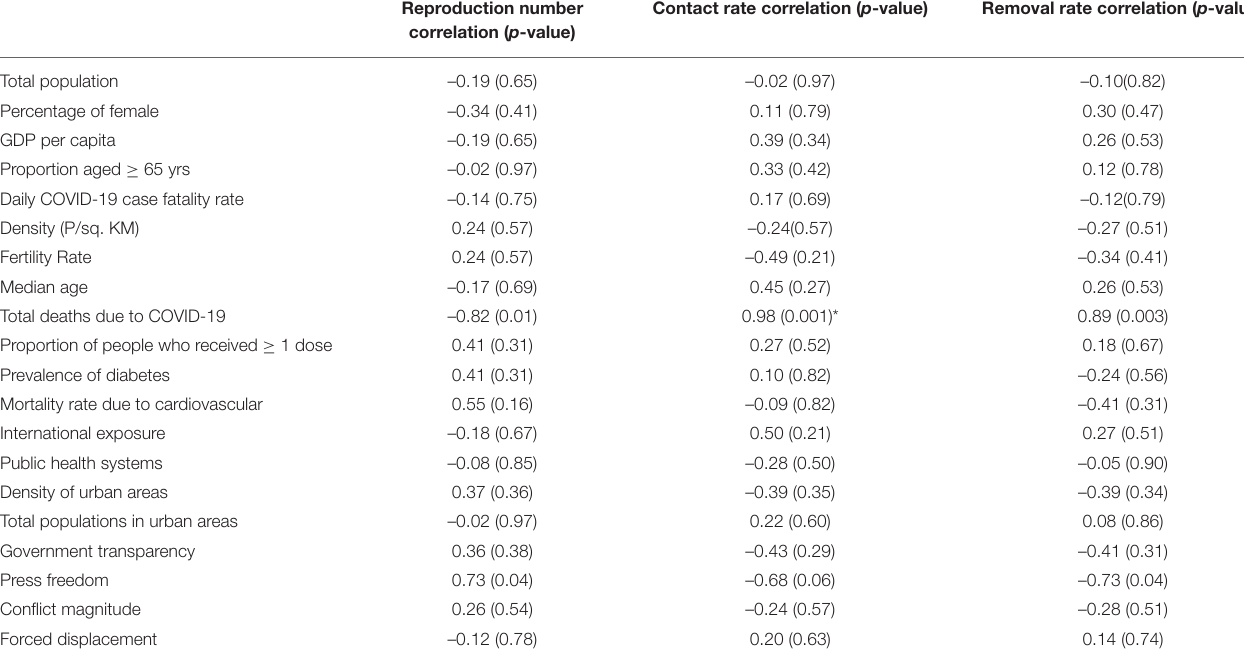
TABLE 3 | Association of reproduction number, contact rate, and removal rate with socioeconomic determinants.